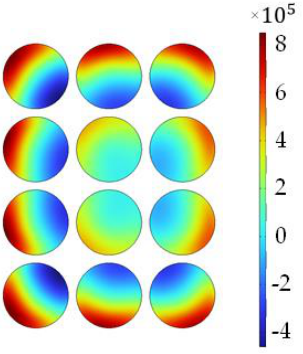
Figure 12. The influence of the skin effect on the current density of turn 1 (A/m 2 ) when turn 1 is excited by 1 A and other turns are kept at 0 A at a frequency of 100 kHz.